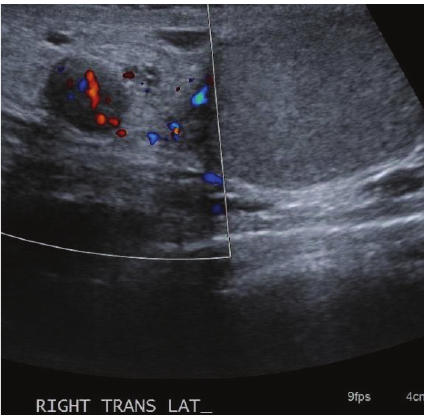
Figure 1: Scrotal sonogram demonstrating a 0.7 × 0.8 × 0.6cm hypoechoic, vascular, heterogeneous lesion superior to the normal right testicle.